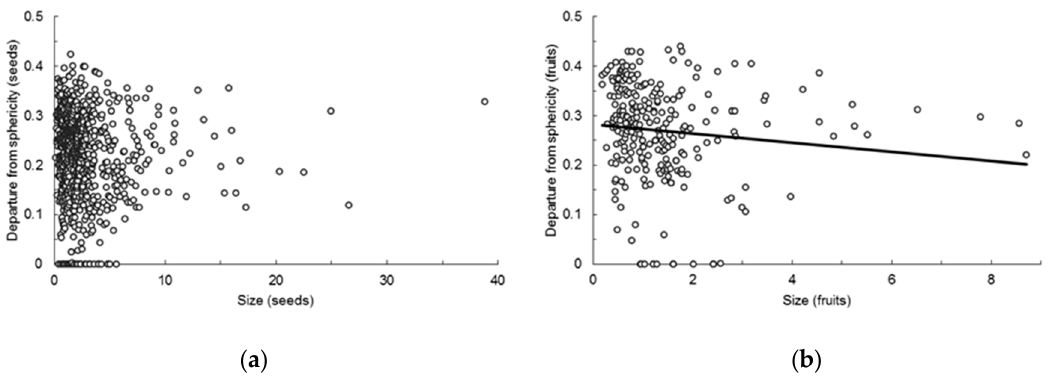
Figure 1. Observed and estimated relationship between departure from sphericity (square root transformed) and size (volume cubic root transformed) of: ( a ) Seeds; ( b ) fruits. All diaspores had known length, width, and thickness.